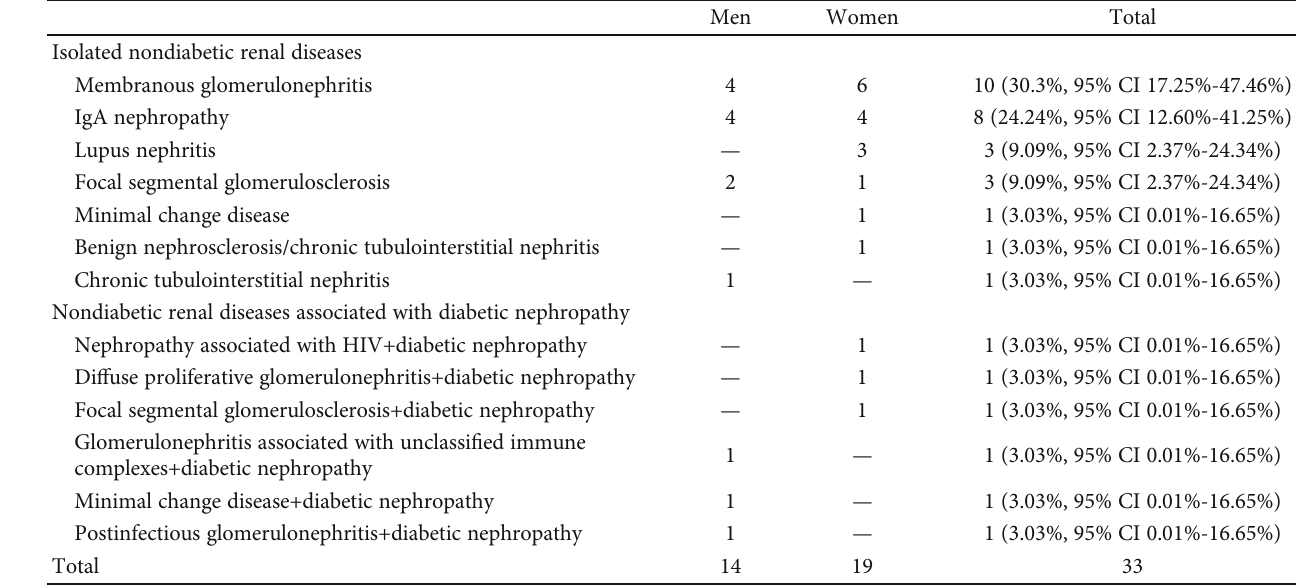
Table 2: Glomerular disease diagnoses.